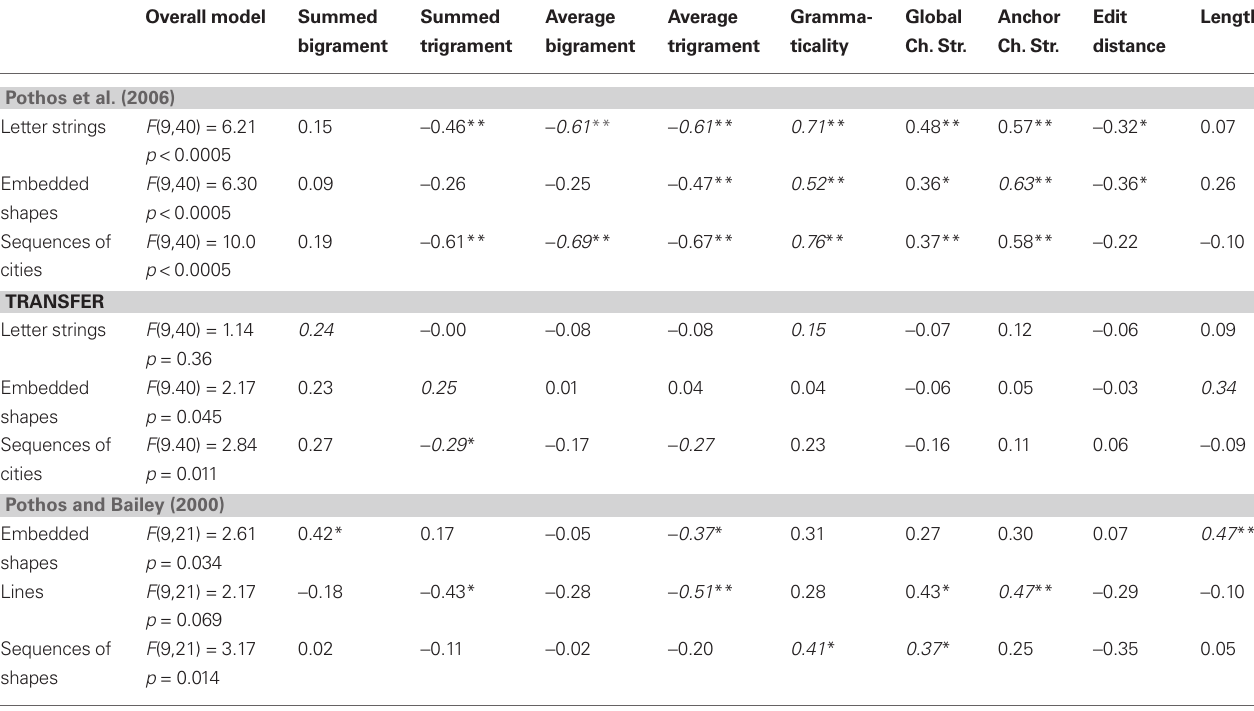
Table 1 | The correlation of the four entropy measures for AgL, and the other AgL performance measures considered in this work, with average grammaticality endorsements for the test items in the nine AgL conditions of Pothos et al. (2006) and Pothos and Bailey (2000) . Note that there were 50 test items in the Pothos et al. (2006) conditions and 32 in the Pothos and Bailey (2000)